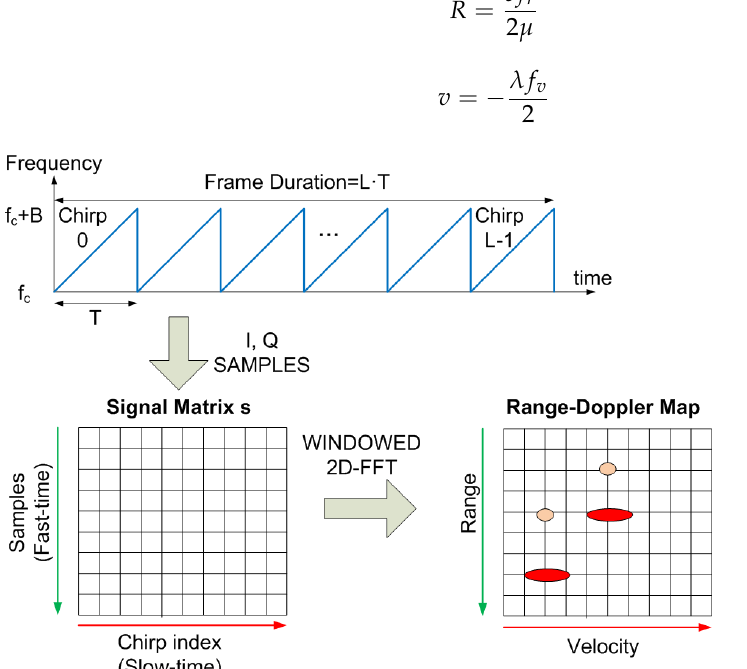
Figure 6. Diagram of the transmitted signal and calculation of the range–Doppler matrix from the I and Q samples